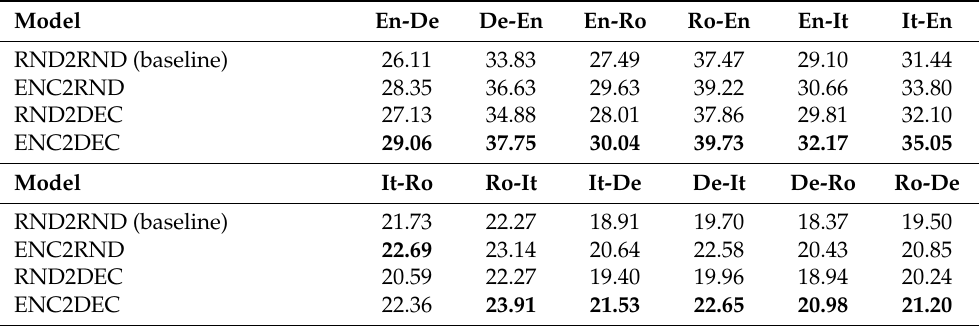
Table 5. BLEU scores of the fine-tuning models with partial module reusing. We indicate the best scores with bold